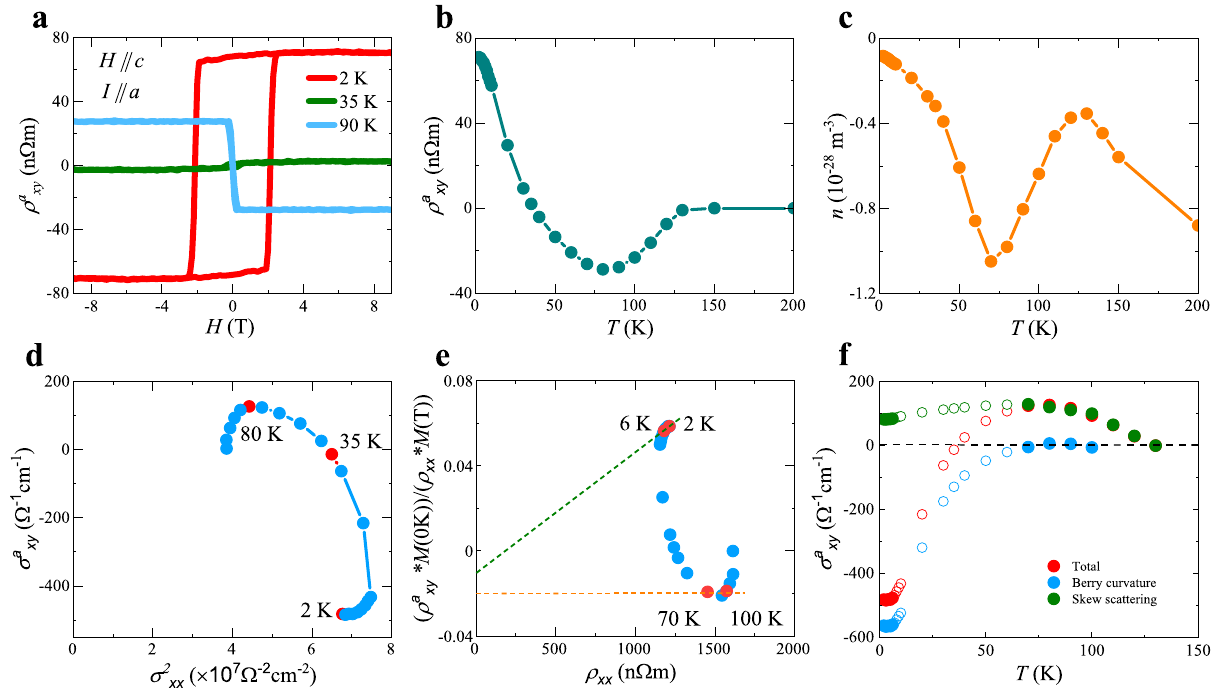
Fig.2|AnomalousHalleffectofUSbTeandthescalinganalysis.a Magnetic fi eld dependence of the anomalous Hall resistivity ρ a xy of USbTe single crystal at three different temperatures, showing a clear sign change of AHE upon cooling, well (solid symbols), the separation of intrinsic Berry curvature and extrinsic skew below T c of125K.Magnetic fi eldisappliedalong c axisandelectriccurrentisalong a axis. b Temperature dependence of anomalous Hall resistivity ρ a scattering contribution is based on established scaling relation with no additional xy in zero mag- assumptions. In the temperature range of 6 – 70K (circle symbols), the exact tem- netic fi elds. c Carrier density extrapolated from the slope of theHall resistivity asa perature dependence of each part is not known and is estimated using the functionoftemperature.Carriersremaintobeelectronsforthewholetemperature assumption discussed in the main text for range. d σ a xy as a function of σ 2 xx , showing that σ a xy isindependent of σ 2 xx below 6K. e ρ a xy M (0K)/( M ρ xx )asafunctionof ρ xx .Theslopeoftheplotrepresentstheintrinsic